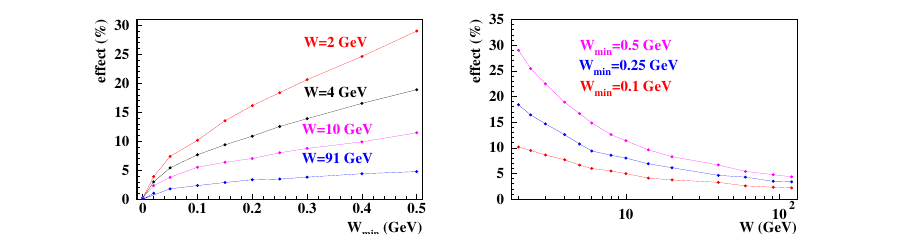
Figure 1. The dependencies of the identity e ff ect on the cut W min on invariant mass for a few energies (left) and on the energy W at the given cut